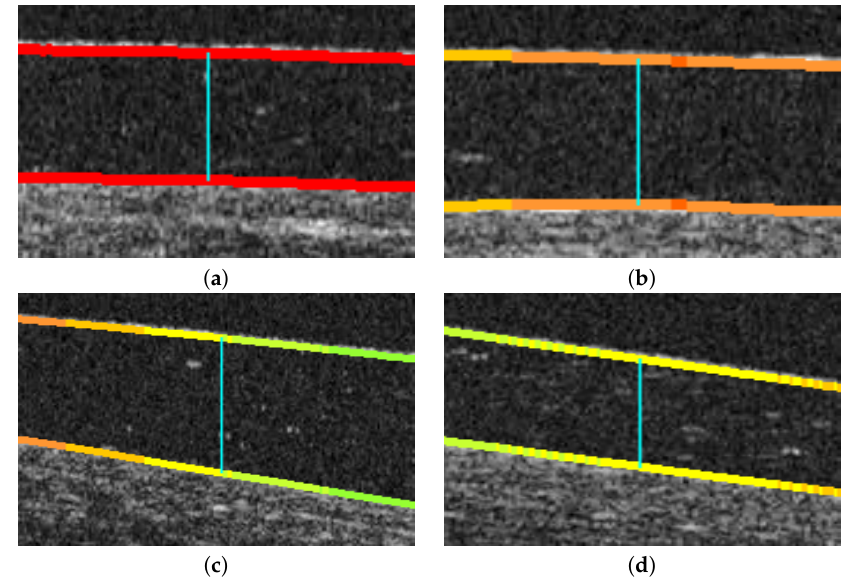
Figure 10. Illustration of the main limitation of the vertical line paradigm for the calculation of the distance between the cornea and the SCL. ( a , b ) Examples of correct applications of the vertical line metric. ( c , d ) Examples of the limitations of the vertical line paradigm in the case of leaning regions of the image, where the vertical distance does not accurately measure the cornea–CL